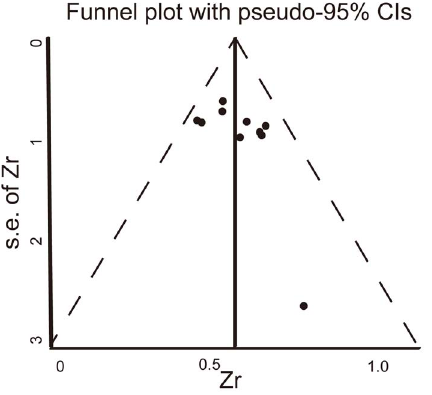
Figure 3. No publication bias was detected using a filled funnel plot with pseudo-95% (CIs) of results of 10 studies. Zr, transformed correlation coefficient (r); s.e., standard error.